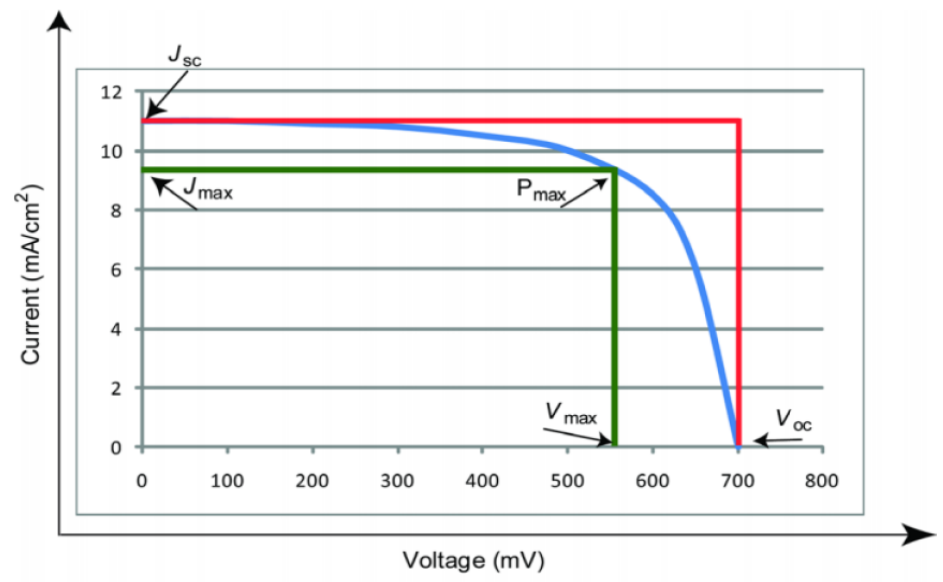
Figure 2. Definition of the photovoltaic parameters of a solar cell [10].